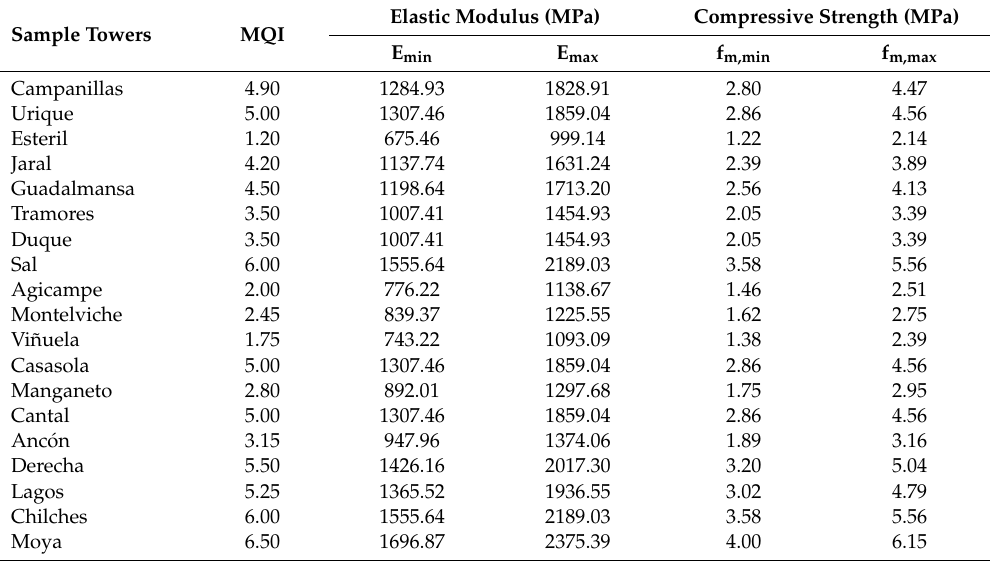
Table 3. Mechanical Properties and Strength Characteristics of the Towers under Study.